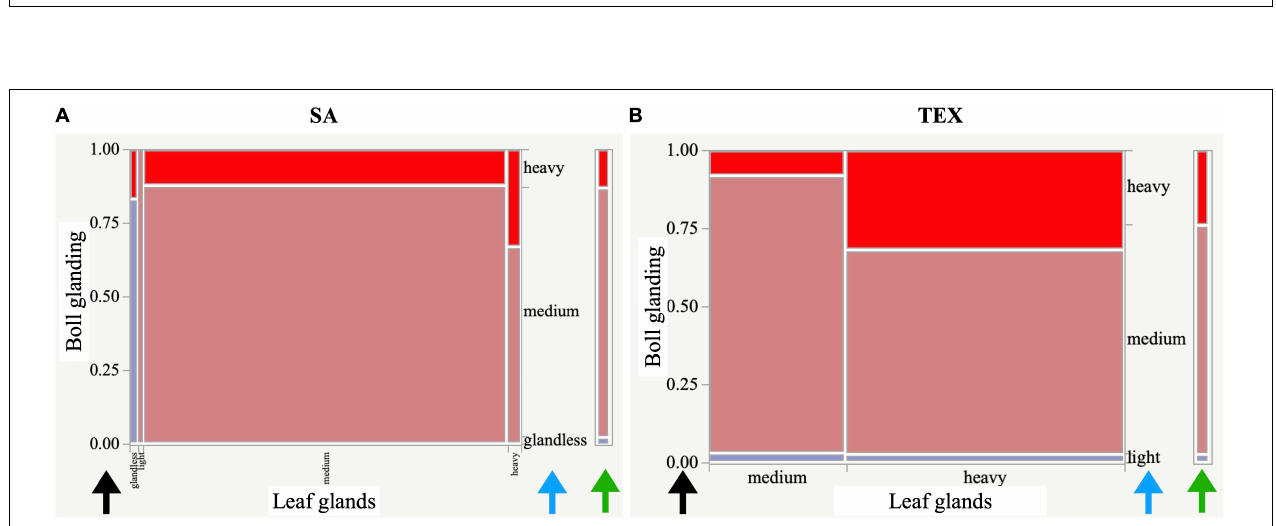
FIGURE 4 | Heat maps of the bivariate descriptor associations were independently evaluated for the SA, TEX, and Gb groups. Larger versions of the TEX and Gb heat figures are in Supplementary Figures 2, 3 . Interactive heat maps linked to the contingency tables and mosaic plots for each association evaluated are available on-line (https://usda-ars-gbru.github.io/categorical_analysis_cotton/). Dark gray boxes indicate p < 0.01. The sample size of accessions for each group is SA: 274, TEX: 471, and Gb: 552.